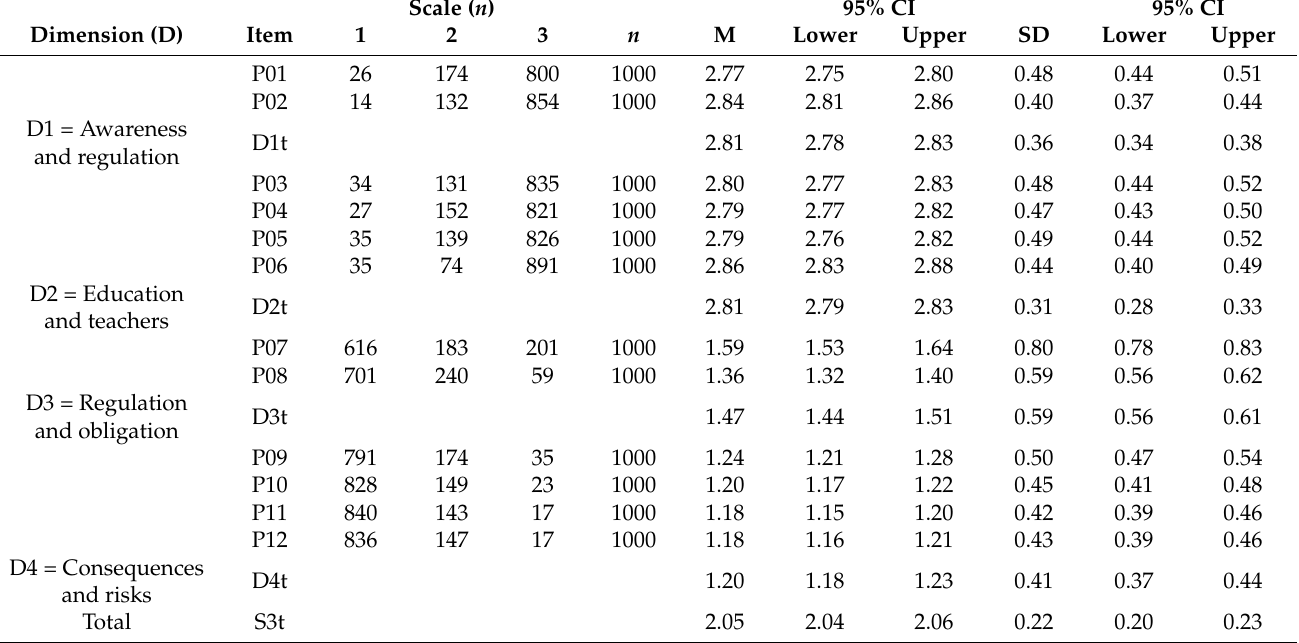
Table 2. Count after application of the